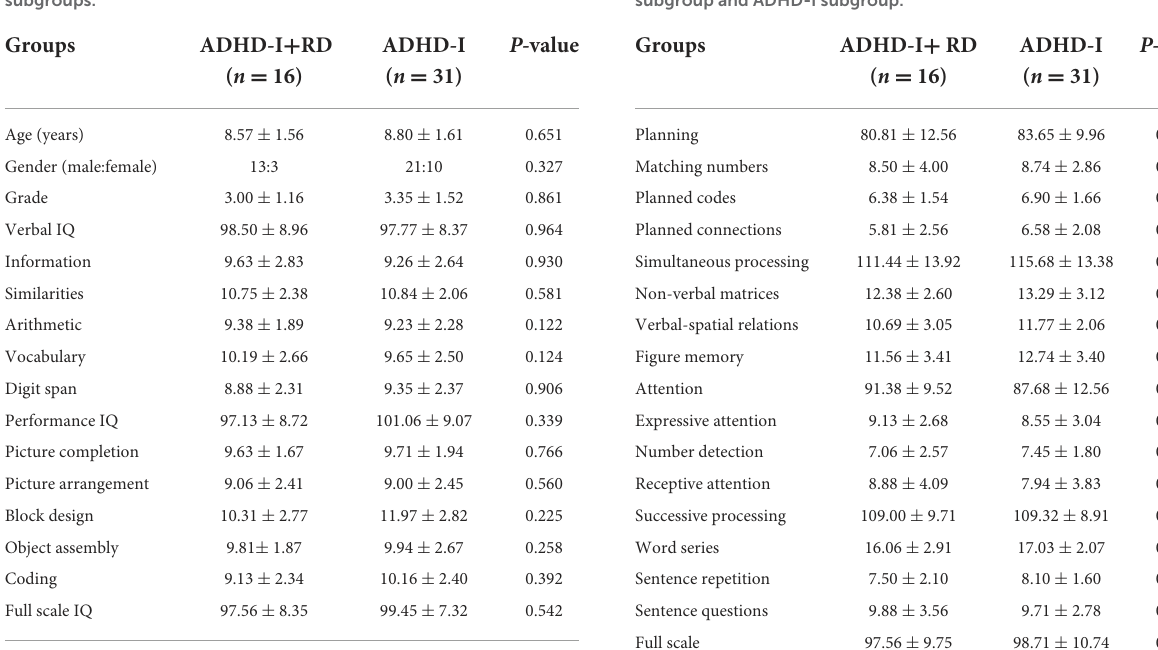
TABLE 3A Basic information of the ADHD-I + RD and ADHD-I subgroups.